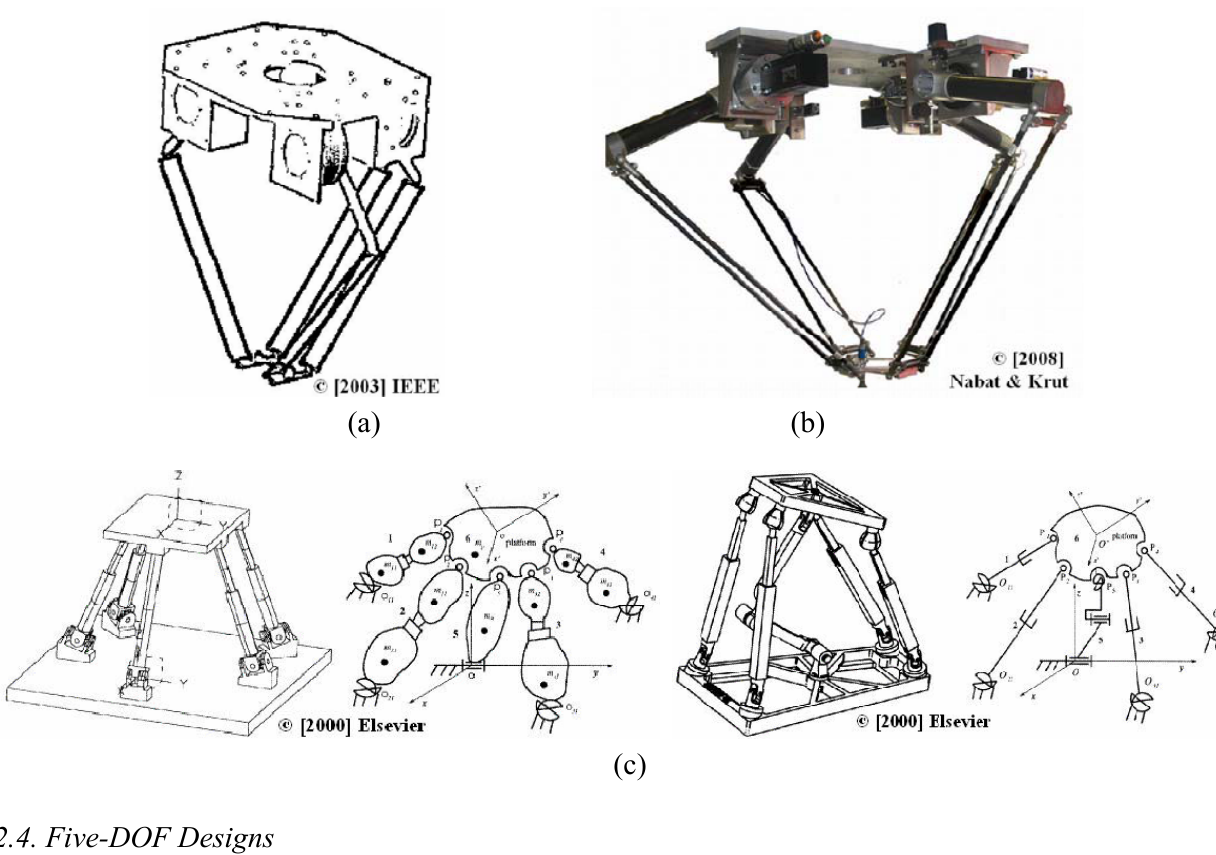
Figure 3. Four-DOF mechanisms: (a) Krut design (reprinted from [29] with permission from IEEE). (b) Nabat design [30] (reprinted with permission from Krut). (c) Wang analysis (reprinted from [31] with permission from